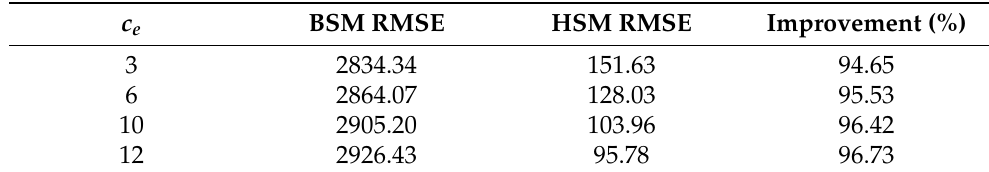
Table 1. Comparison between BSM and HSM in the period 15 October–5 November 2020, using RMSE 1 .